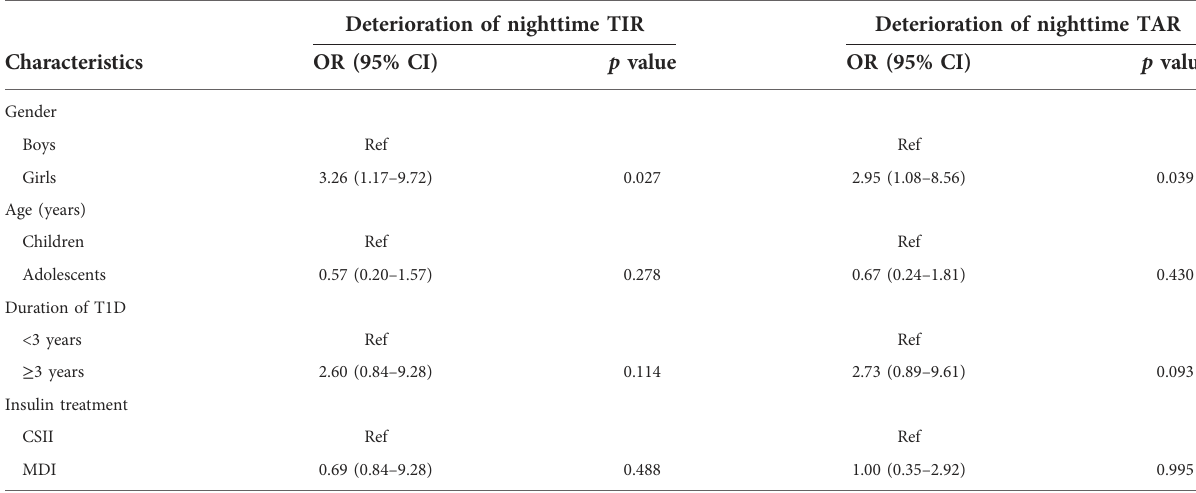
TABLE 3 The relationship between the participants ’ characteristics and the worse nocturnal glycemic control in schooldays by using binary logistic regression